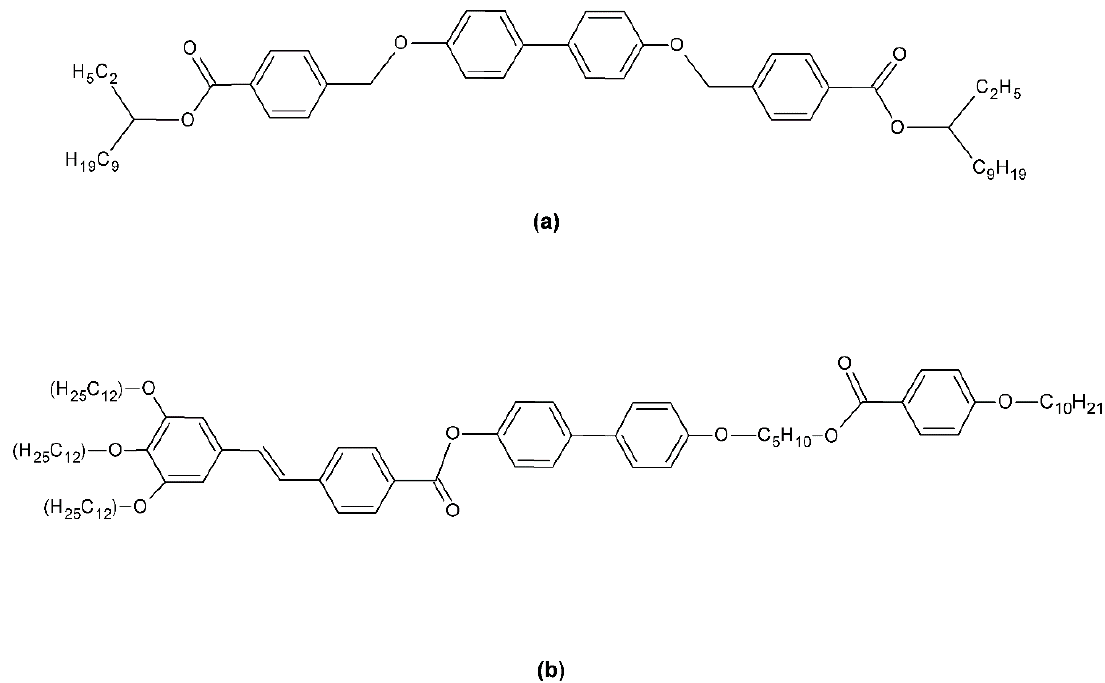
Figure 1. Molecular structure of the two rod-like liquid crystals: ( a ) the symmetric mesogen, 9/2 RS/RS ; ( b ) the asymmetric dimer, L1 .